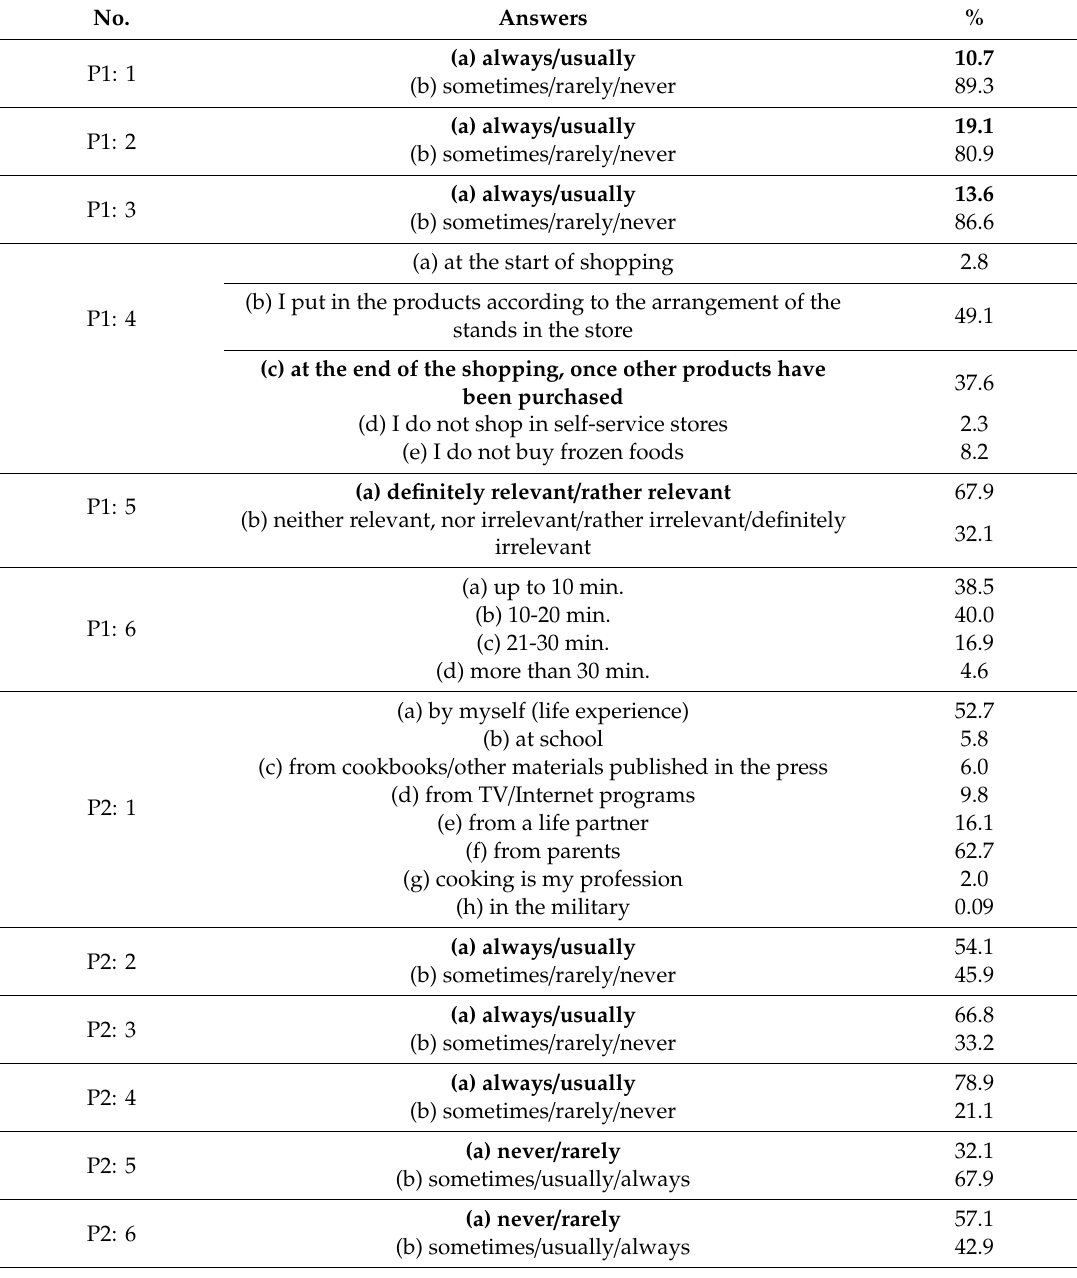
Table 2. Respondent’s food handling practices during shopping and at home